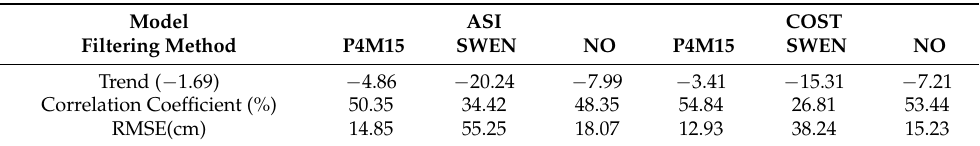
Figure 5. The Swarm-TWSC time series and the long-time trend with different filtering methods and GRACE-TWSC’s in Basin 1. The left one is Swarm from ASI and the right one is Swarm from COST. Table 5. The results of Swarm-TWSC of different filtering methods compared with GRACE-TWSC in Basin 1.